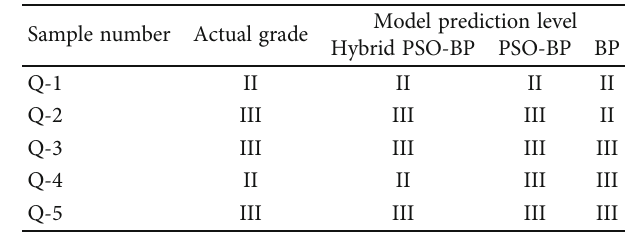
Table 2: Actual rating and indicator data of tunnel to be predicted. Sample